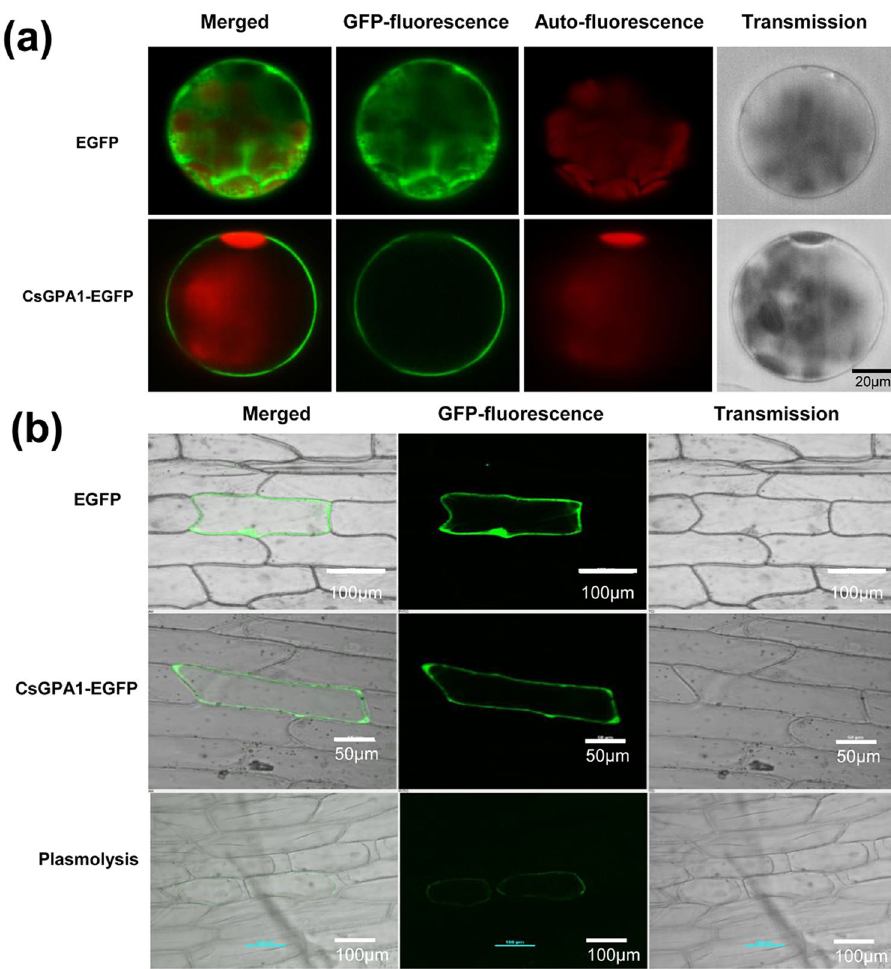
Figure 2. Subcellular localization of CsGPA1-GFP. ( a ) Subcellular localization of CsGPA1-enhanced green fluorescent protein (EGFP) in Arabidopsis thaliana mesophyll protoplasts. ( b ) Subcellular localization of CsGPA1-EGFP in onion epidermal cells after plasmolysis. The plasmid encoding EGFP alone served as the control. Green represents EGFP fluorescence, while red represents chlorophyll fluorescence. Scale = 20, 50 and100 µ